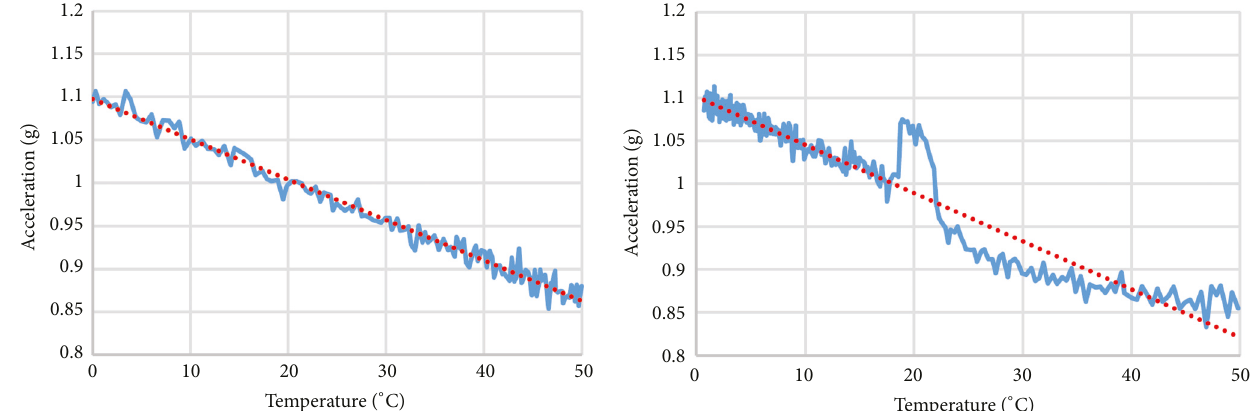
Figure 2: Dependence of the accelerometer Z-axis values (1g – 9.81 m/s 2 ) upon the temperature during rapid (5 ∘ C/min) heating (left) and cooling